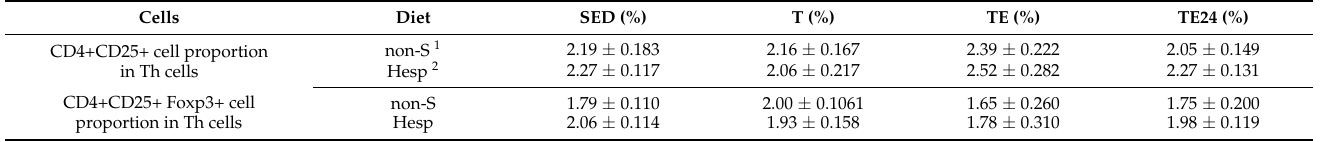
Table 1. Proportion of the activated and regulatory Th cells in